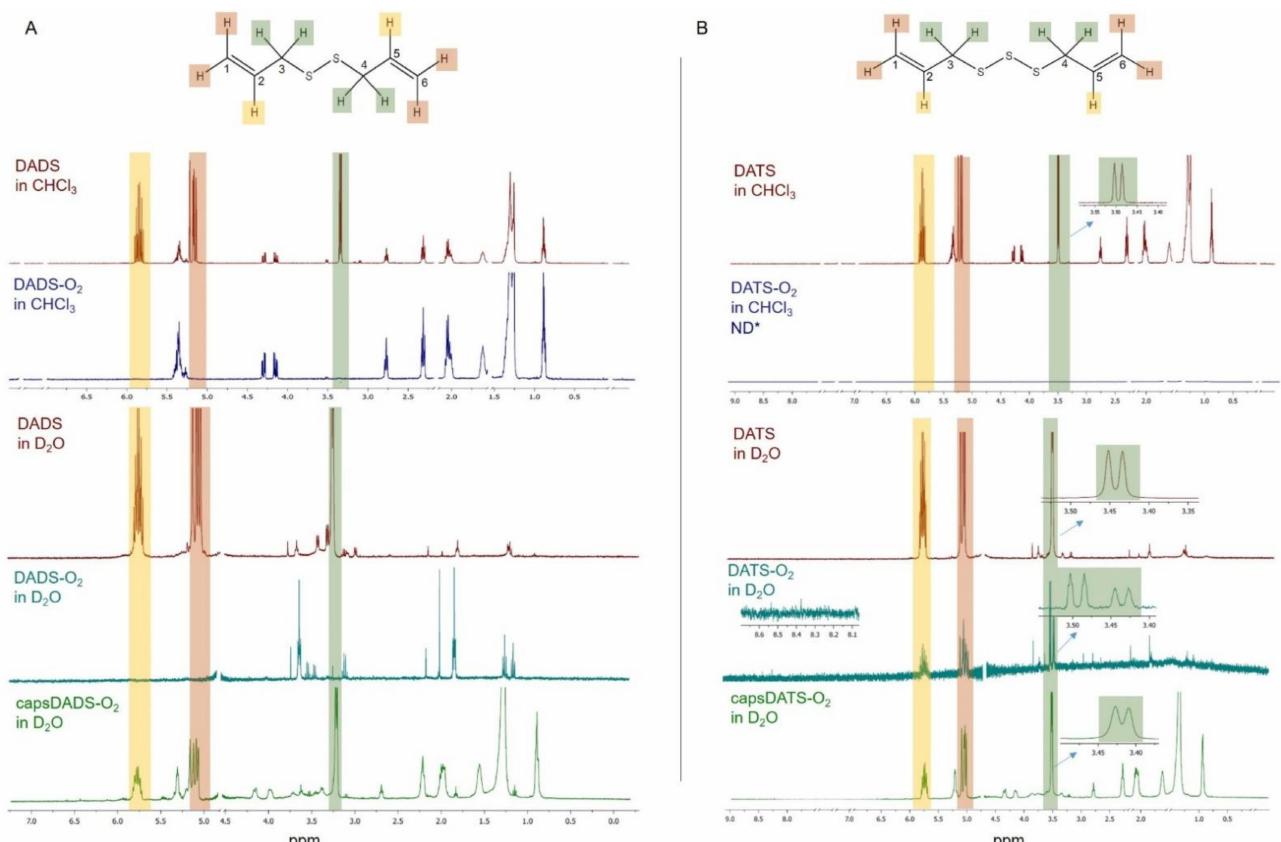
Figure 3. Nuclear magnetic resonance ( 1 H NMR) spectra of native DADS, after oxidation (DADS-O 2 ) and the encapsulated DADS after oxidation (capsDADS-O 2 ) measured either in CHCl 3 -d or D 2 O (panel ( A )). Analogous data for DATS are presented in panel ( B ). Signals from solvents were cut out as described in Methods. * ND, signals not